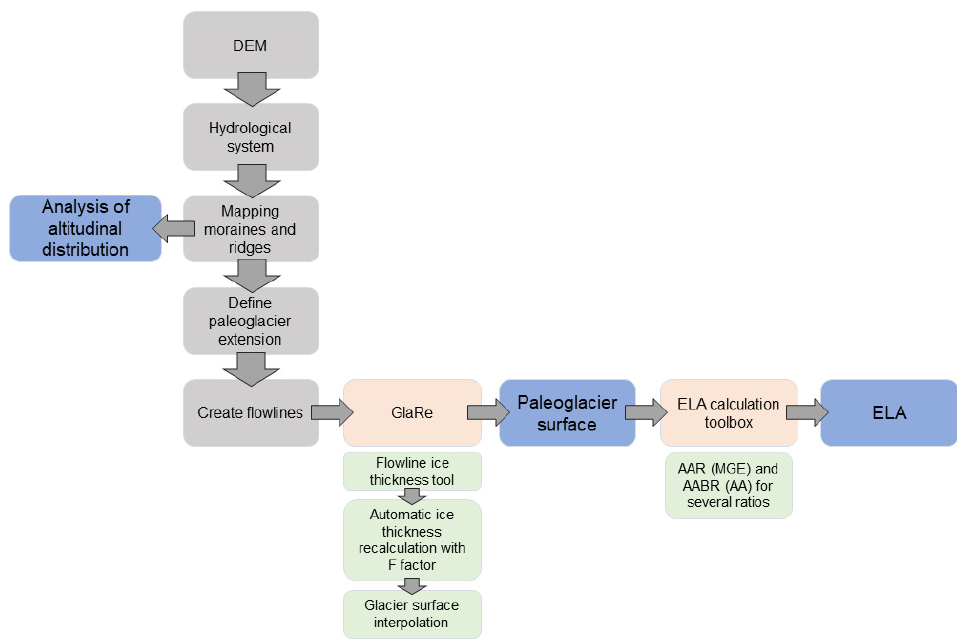
Figure 3. Project workflow from the raw data to the results and the main tools used. Orange boxes represent the main tools, with the concrete functions in the green boxes, while the blue boxes represent the final